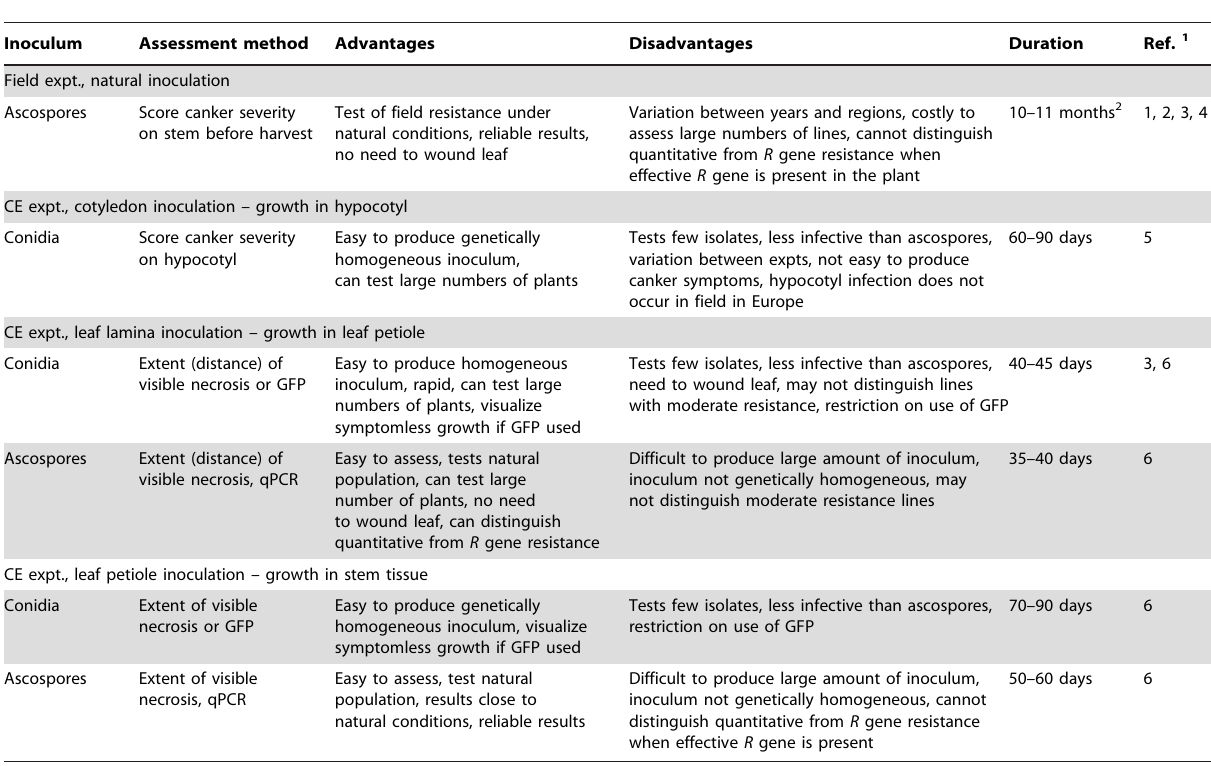
Table 2 . Comparison of different methods for assessing Brassica napus quantitative resistance against Leptosphaeria maculans .